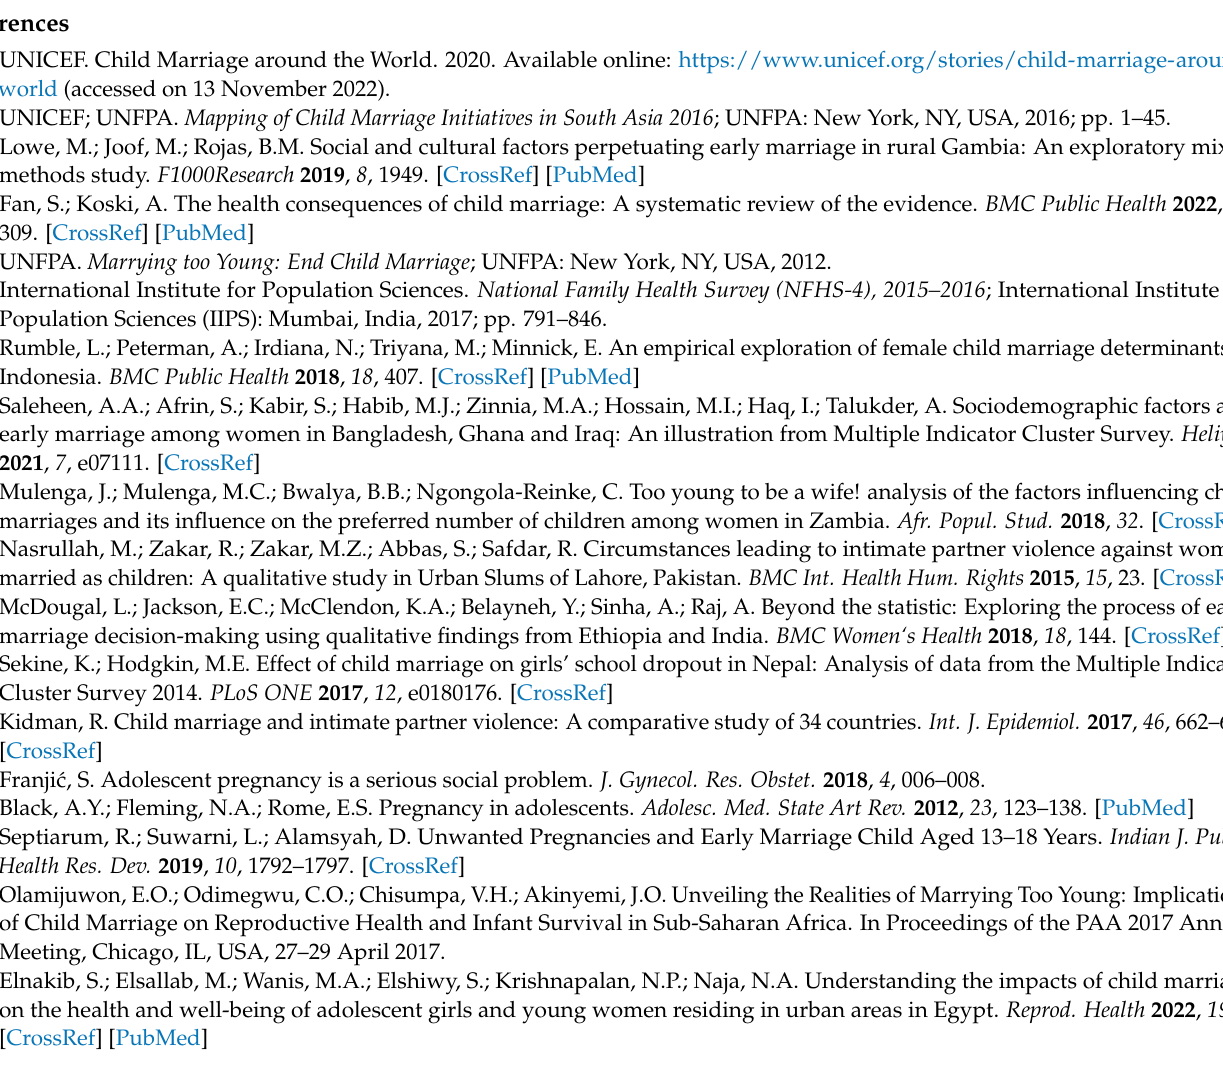
Table S2: PRISMA 2020 checklist. Reference [61] is cited in the supplementary